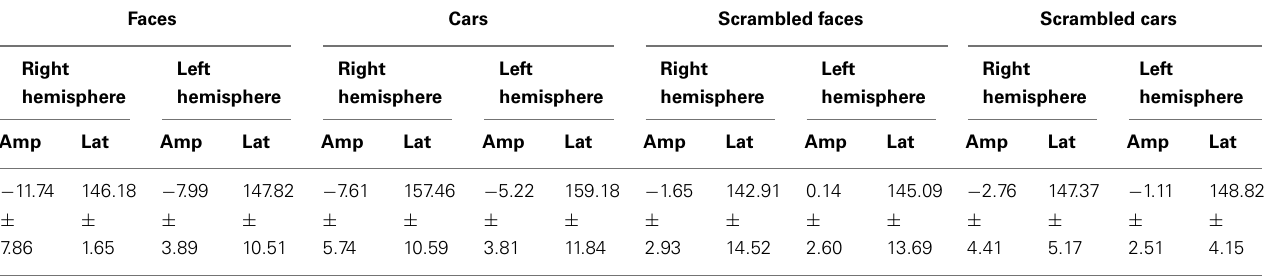
FIGURE 3 |Visual ERPs elicited by all stimulus types in the group of younger controls (A) and age-matched controls (B) highlighting the sensitivity to faces of the P1 and N170 (the ROIs are based on four channels indicated on the topographic maps). Note that the P1 was